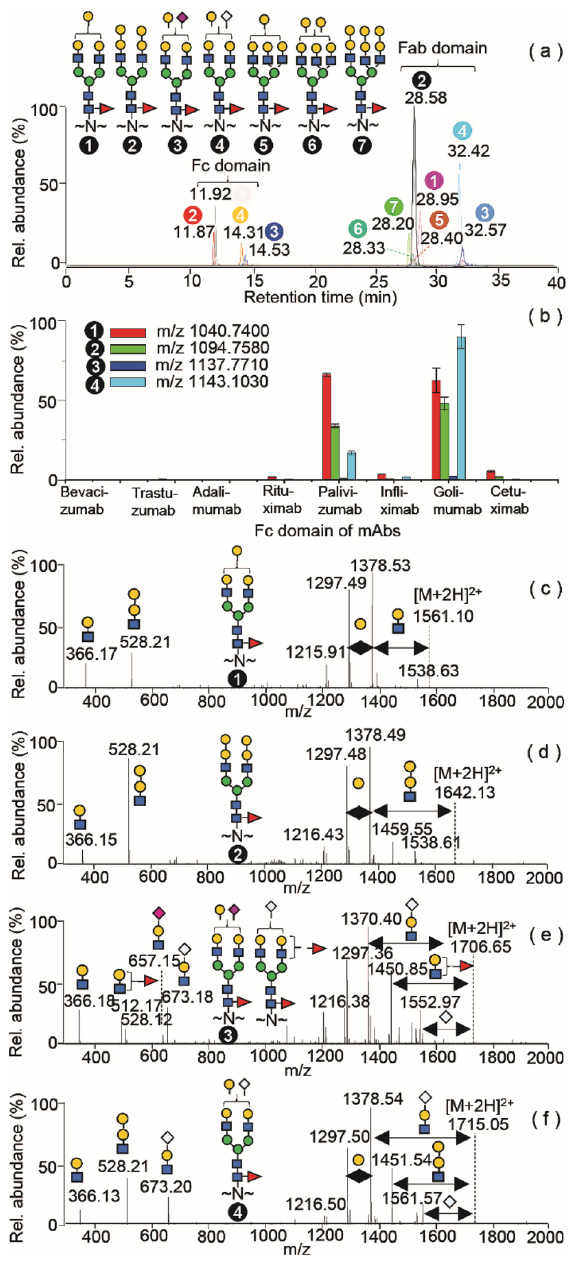
Figure 1. α-Gal containing N -glycopeptides of mAbs. ( a ) Overlaid EICs of the biantennary Fc and triantennary Fab N -glycopeptides of cetuximab; ( b ) Relative abundances of the Fc N -glycopeptides of eight mAbs examined in triplet measurements, plotted as the calculated values of peak areas from the mean and standard deviation. ( c – f ) MS/MS spectrum of the individual glycopeptide containing an α-Gal composition illustrated by compound numbers within the black circles, respectively, and the precursor ions are shown in the figure ( b ). The compound 3 is a representative structure derived from a mixture of isobaric glycans containing Neu5Ac and